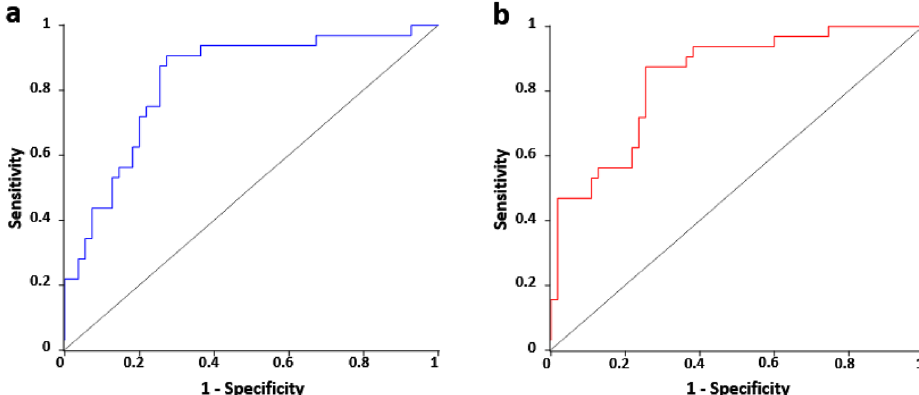
Figure 2. Distinguishing CLTI using serum FAS content and other variables. ( a ) Area under the curve containing serum cFAS content, T2D, and smoking status demonstrates 83% accuracy in distinguishing CLTI patients. ( b ) When adjusted for age and sex, accuracy improved marginally to 84%. Diagonal line represents random probability (no distinguishing ability).